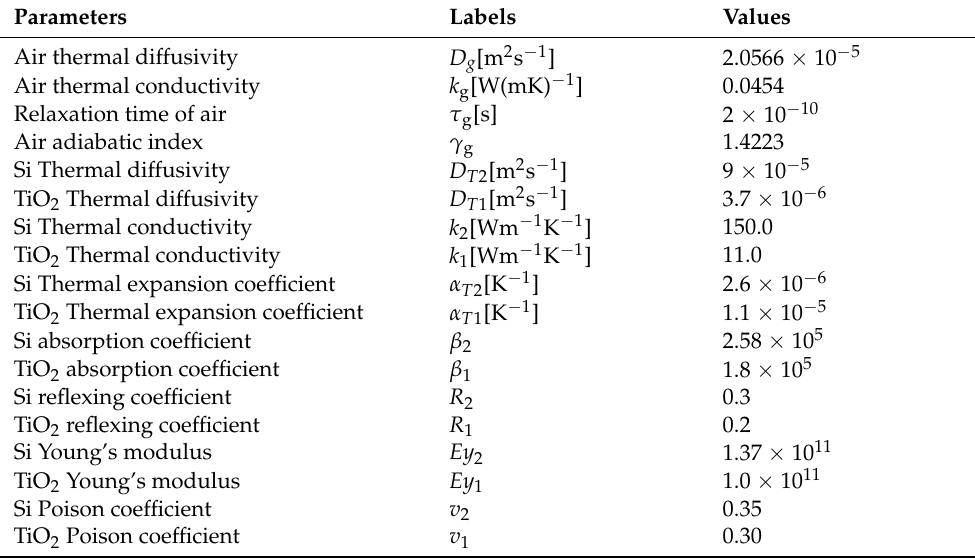
Table 1. Values of basic parameters used for PA simulation TiO 2 thin-film deposed on Si substrate.